Question: In a single sentence, describe what this figure presents.
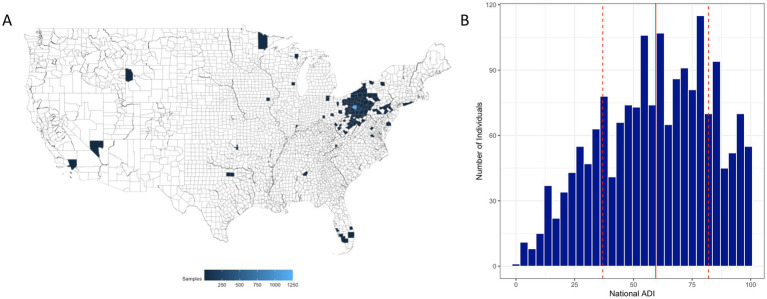
Answer: Individuals in the study cohort were primarily from western Pennsylvania, West Virginia, and Ohio, and the average area deprivation is higher than the national average. (A) Chloropleth of county-level counts of individuals included in this study. (B) Histogram of counts of individuals binned by national area deprivation index, with a solid red line representing the population mean (compared to the national mean of 50) and dotted red lines representing the first and fifth quintiles of the population.